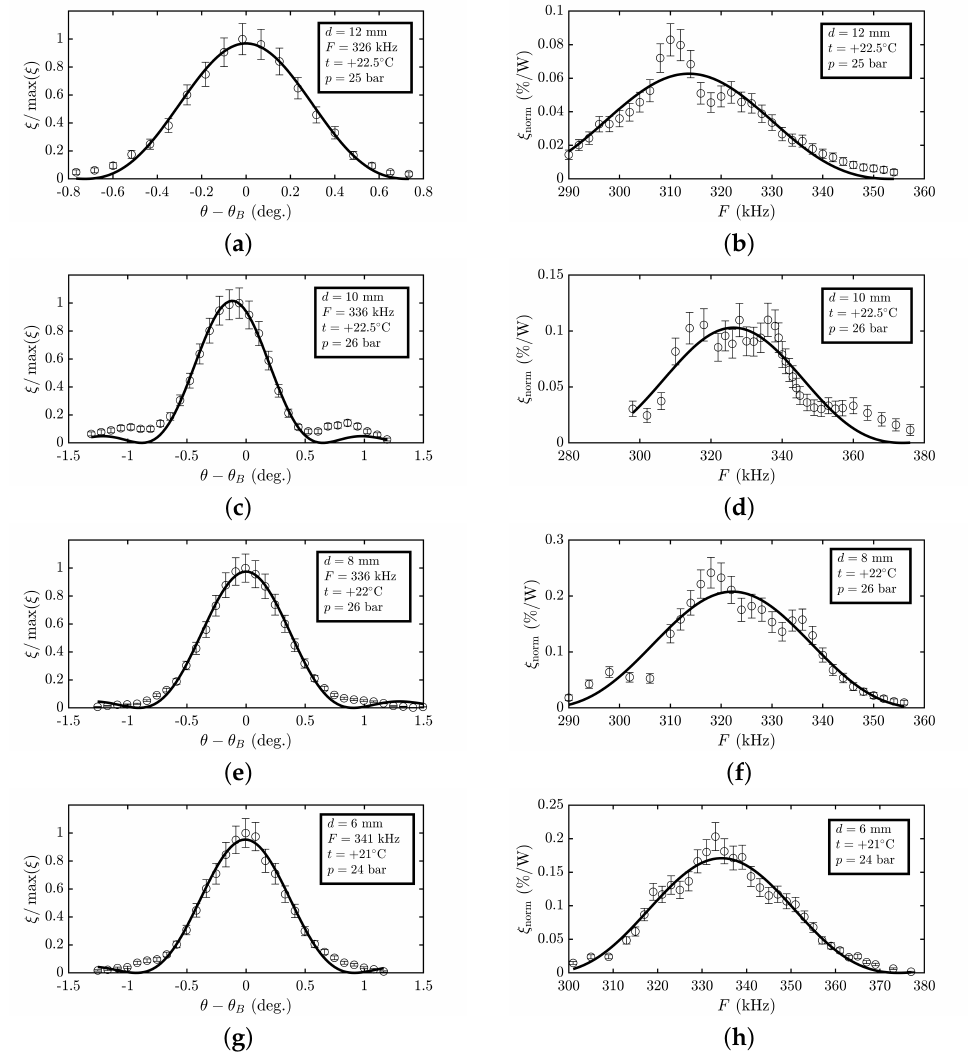
Figure 6. Experimental results: ( a , c , e , g ) AO diffraction efficiency ξ / max ( ξ ) vs. difference between angle θ of incidence of THz radiation on AO cell and Bragg angle θ B ; ( b , d , f , h ) frequency dependence of AO diffraction efficiency per 1 W of applied electric power. Table 2. Characteristics of AO modulator of THz radiation revealed